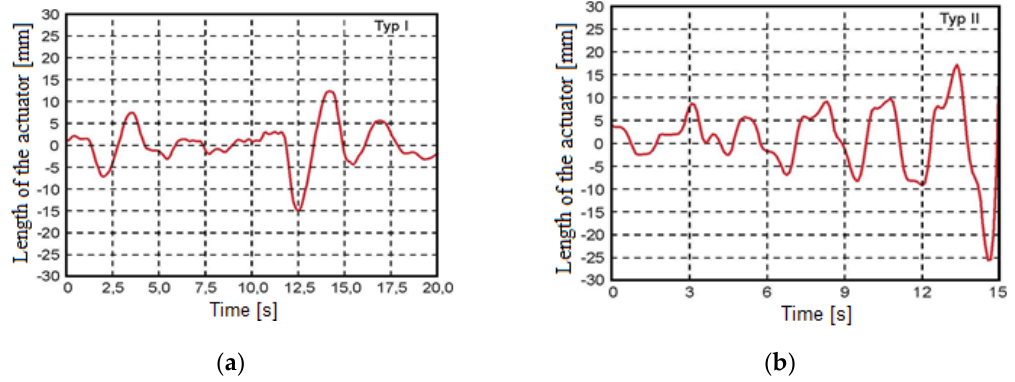
Figure 3. Example of hydraulic actuator displacement during straight-line riding at 30 km/h speed—( a ) hydraulic steering system with mechanical feedback and ( b ) hydraulic steering system with LS and hydraulic amplifier.